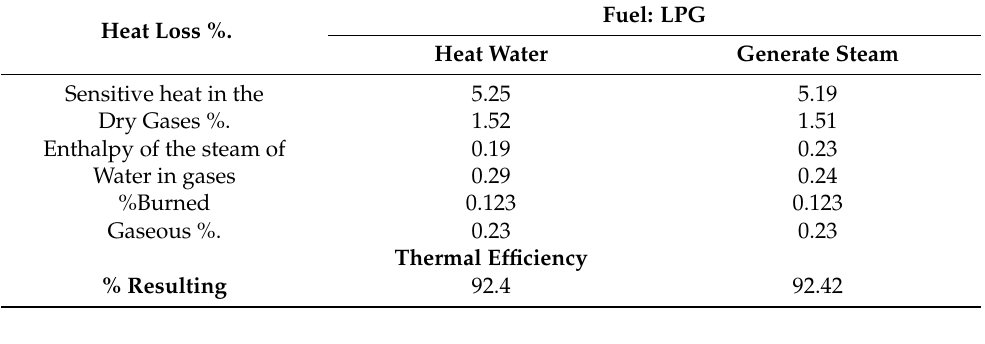
Table 4. Distribution of losses and thermal efficiencies.